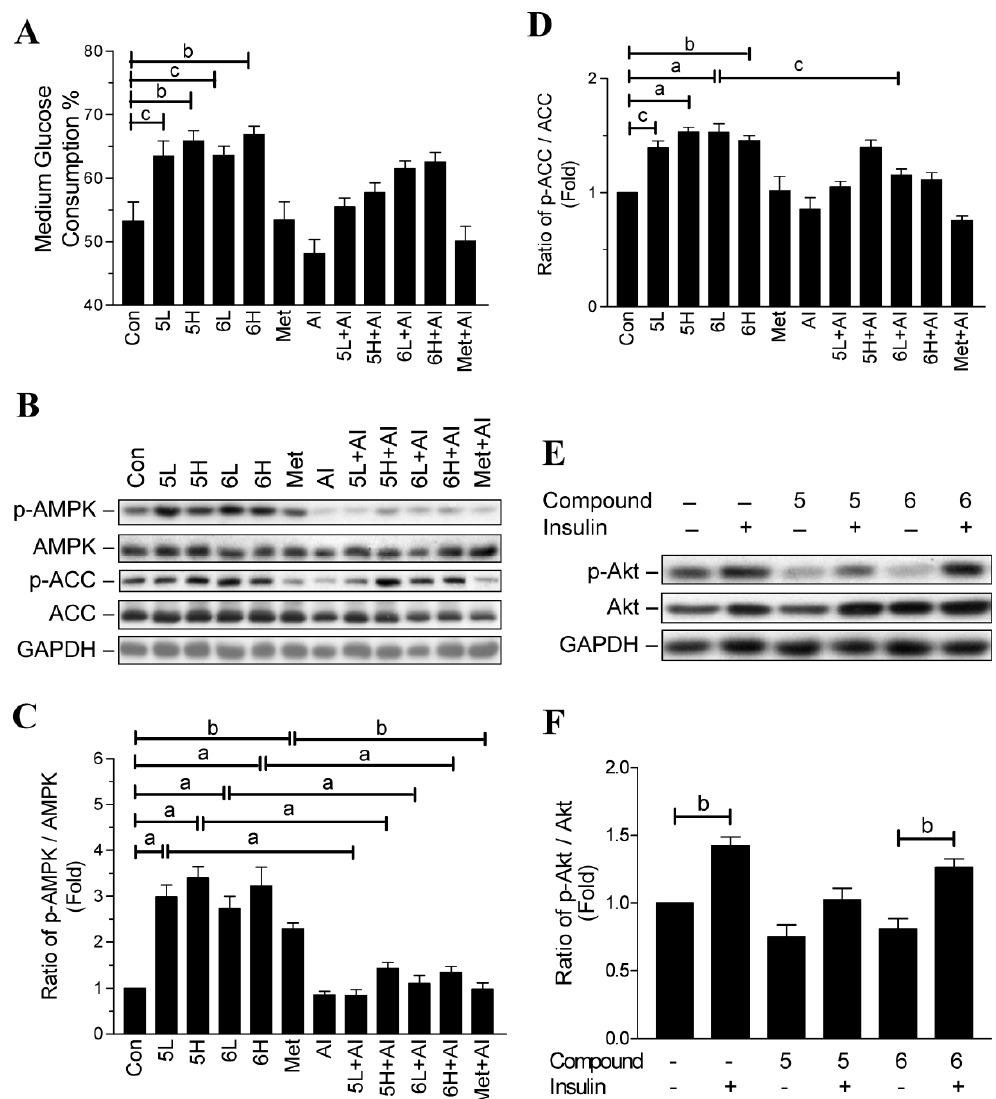
Figure 5. Effects of chalcone derivatives on the glucose consumption, and AMPK and Akt signaling in C2C12 myotubes. ( A ) C2C12 myotubes were pre-treated with or without dorsomorphin (10 µM; AI) for 30 min and then administered a low dosage (15 µg/mL; L) or high dosage (30 µg/mL; H) of compounds 5 or 6 , or 30 µg/mL of metformin. The medium glucose consumption was detected after 12 h of incubation and the cells were harvested for protein analysis; ( B ) Western blotting for phosphorylated and total AMPK and ACC proteins; ( C , D ) the quantitative results for the blots in panel B; ( E ) C2C12 myotubes were treated with 30 µg/mL of compounds 5 or 6 combined with or without insulin (0.32 µM) for 30 min, and then the cells were harvest for phosphorylated and total Akt proteins by Western blotting; ( F ) the quantitative results for the blots in panel E. Data are mean ± SD from three independent experiments. a : p < 0.001; b : p < 0.01; c : p < 0.05.